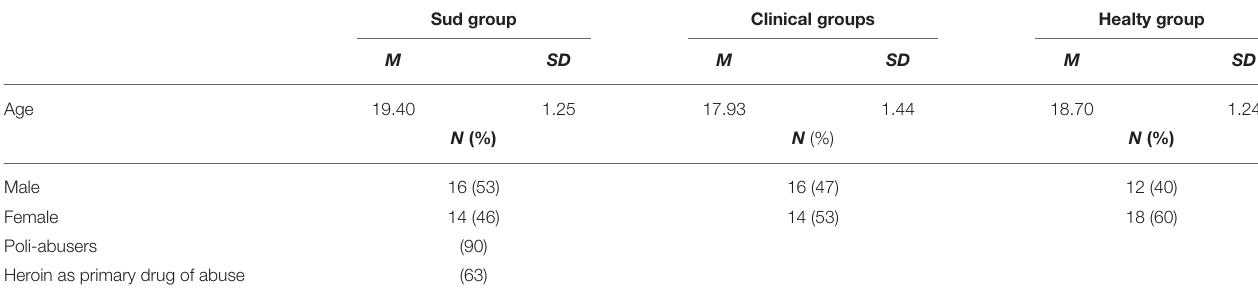
TABLE 1 | Descriptive characteristics of each group.